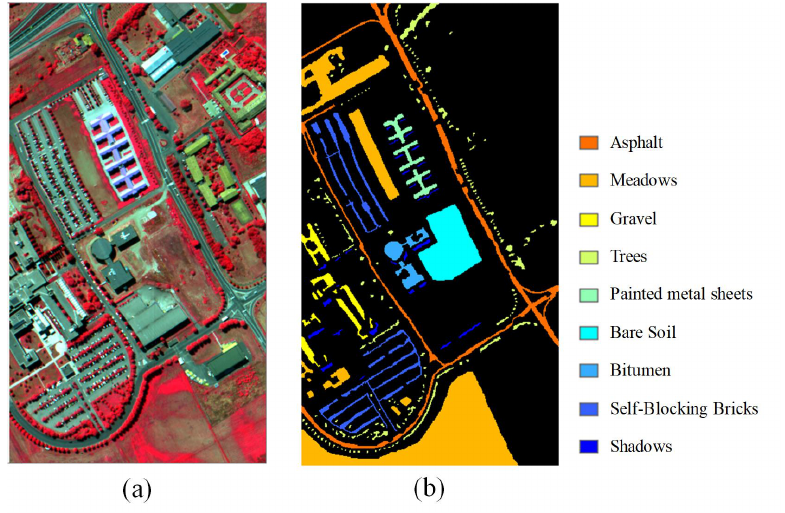
Figure 8. The PaviaU scene: ( a ) false-color composite image; ( b ) ground